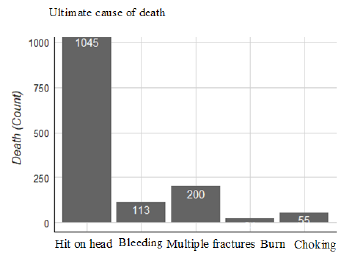
Figure 1. The mortality rate of road traffic accidents in terms of ultimate cause of death during 2011-2015.